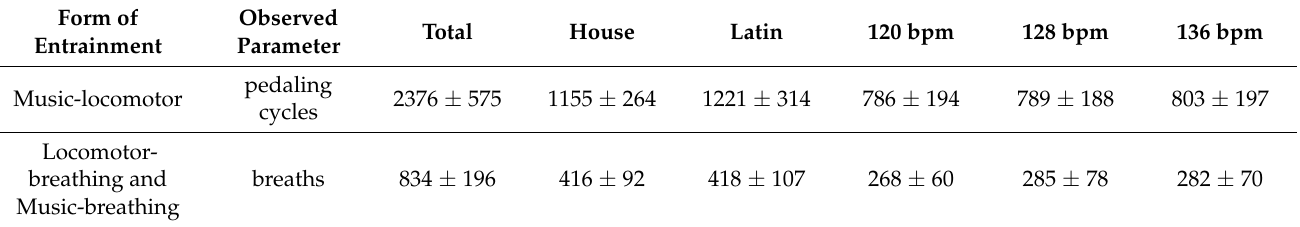
Table 4. Number of observations of the entrainment analyses.